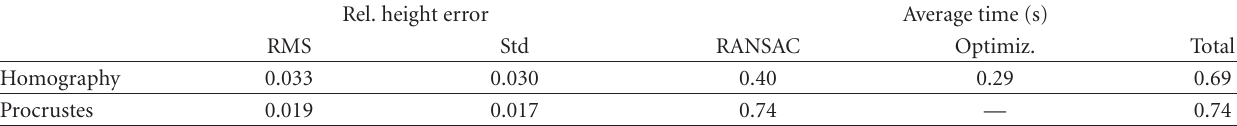
Table 1: Results for relative height with a horizontal ground plane.